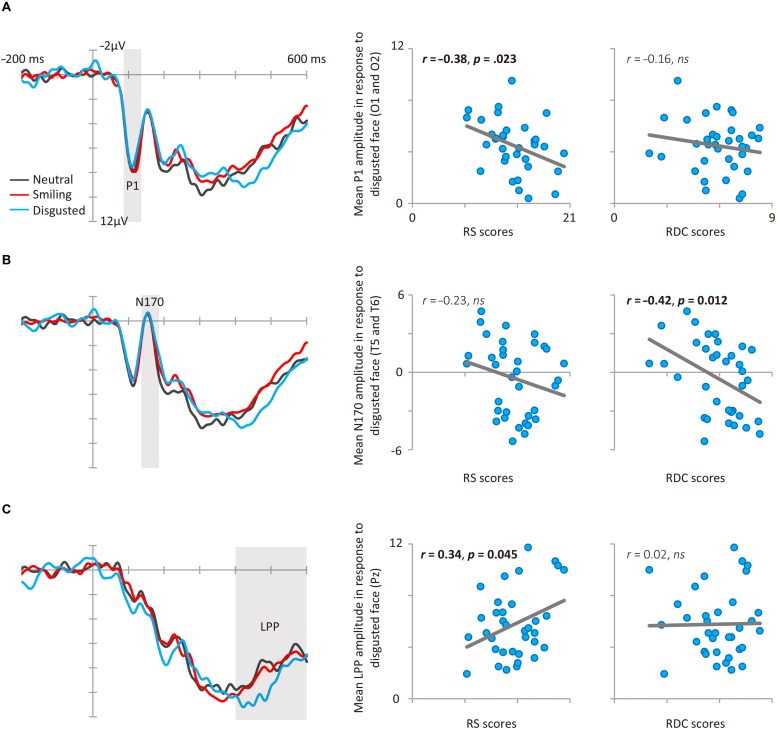
Results of Study 2. (A) P1 event-related brain potential (ERP) results. Average grand mean waveforms (O1 and O2) for facial expressions (left). Correlations between P1 amplitude in response to disgusted faces and RS (middle), RDC (right). (B) N170 ERP results. Average grand mean waveforms (T5 and T6) for facial expressions (left). Correlations between N170 amplitude in response to disgusted faces and RS (middle), RDC (right). (C) LPP ERP results. Grand mean waveforms for facial expressions at Pz (left). Correlations between LPP amplitude in response to disgusted faces and RS (middle), RDC (right).